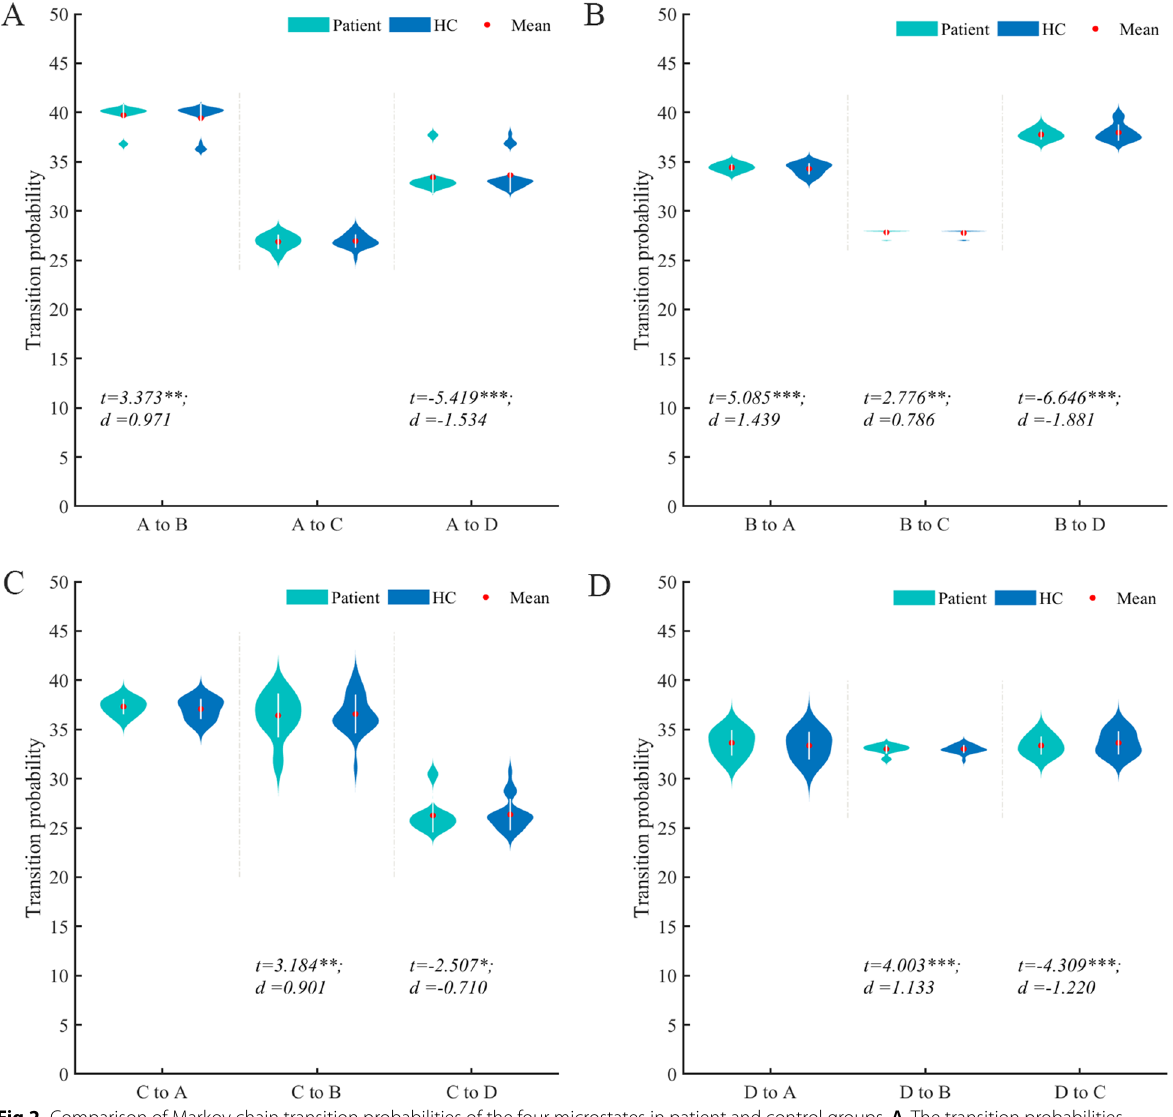
Fig.2 Comparison of Markov chain transition probabilities of the four microstates in patient and control groups. A . The transition probabilities from microstate A to other microstates; B . The transition probabilities from microstate B to other microstates. C . The transition probabilities from microstate C to other microstates. D . The transition probabilities from microstate D to other microstates. The transition probabilities from one microstate to another were calculated using Markov chains and assessed by using GLM with age and sex as covariates. The results have been further confirmed by permutation test (iteration 10,000) using residuals of microstate parameters after GLM. HC, healthy control; d , the effect size = Cohen’s d . *** P < 0.001, ** P < 0.01, * P <